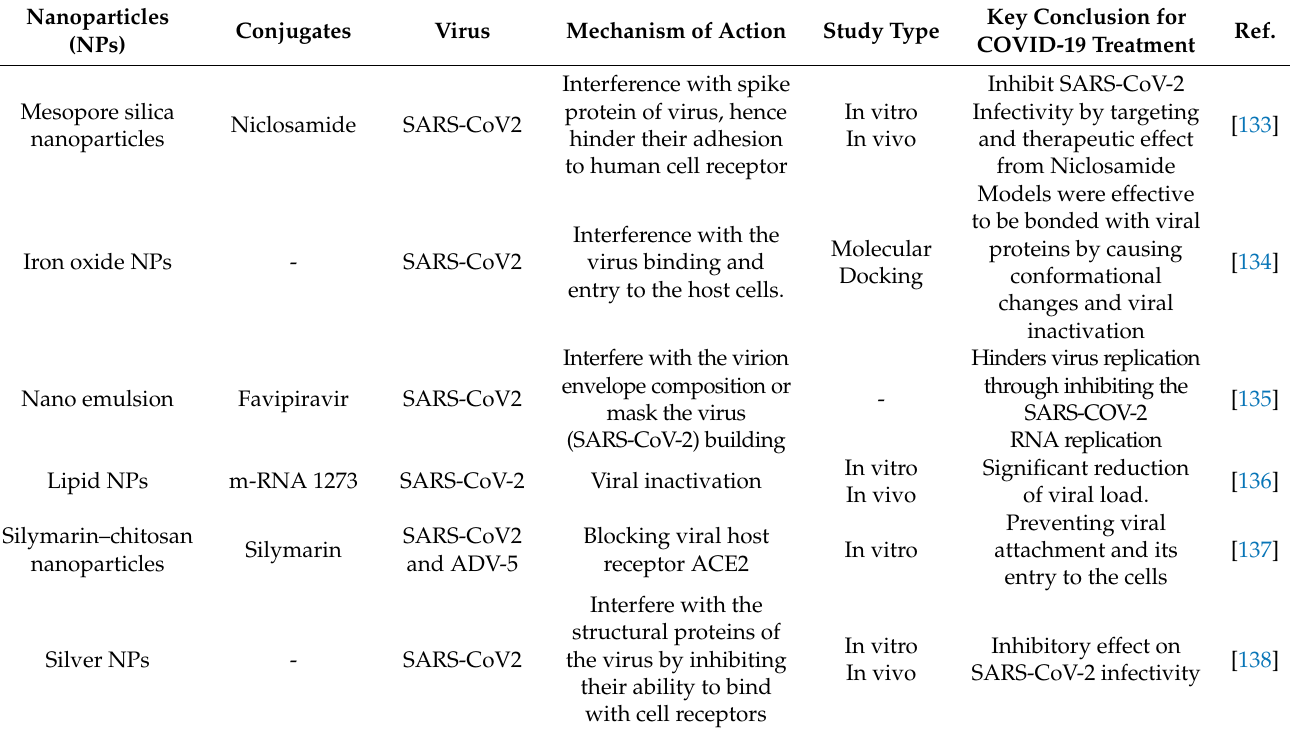
Table 2. Therapeutic application of nanoparticles in